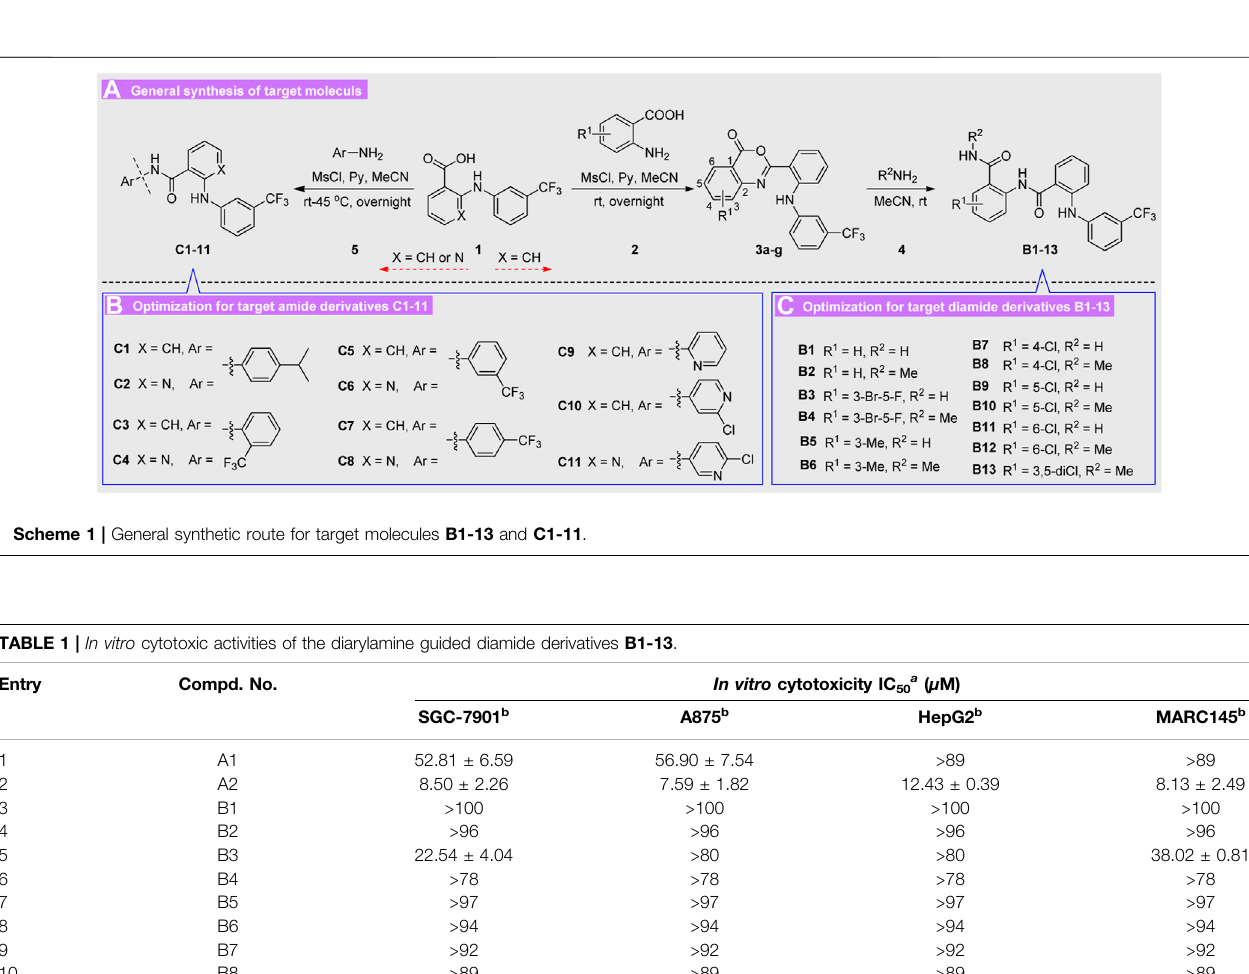
FIGURE 3 | Design strategies for diarylamine-guided amide